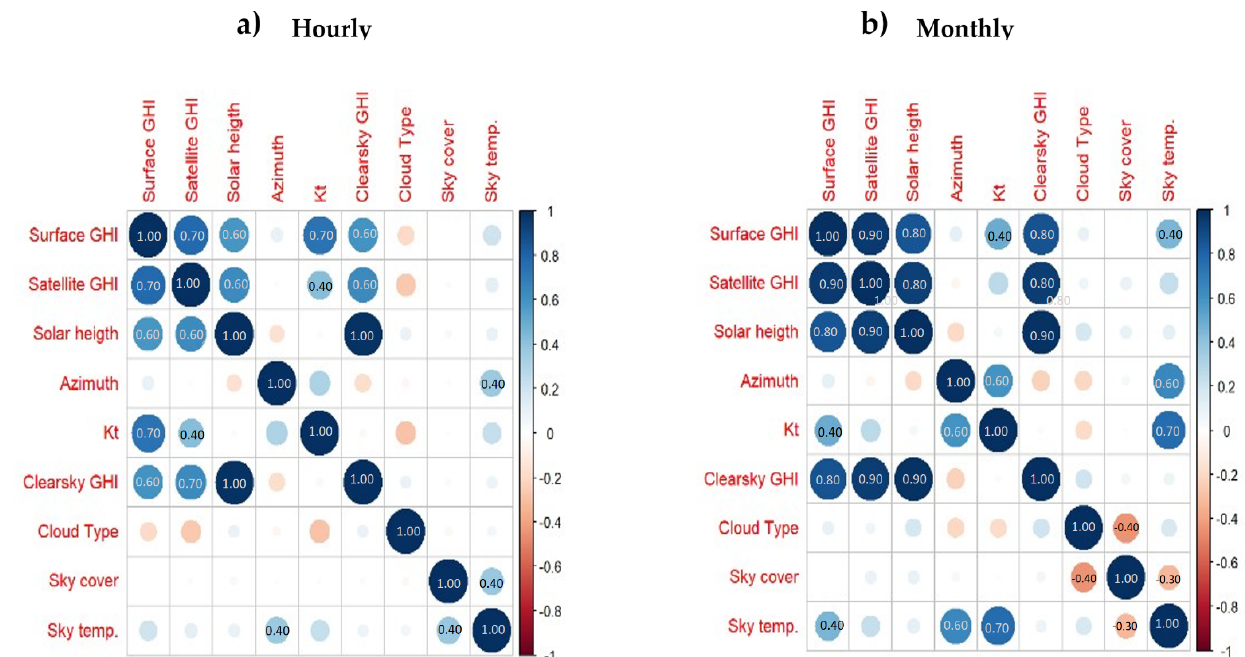
Figure 3. Pearson’s correlation matrix, comparison between hourly and monthly GHI profiles. ( a ) Shows the hourly profile. ( b ) Shows the monthly profile. The greater diameter circles with darker shades show a better correlation. Blue, red and white colors represent direct, inverse and null correlation respectively.